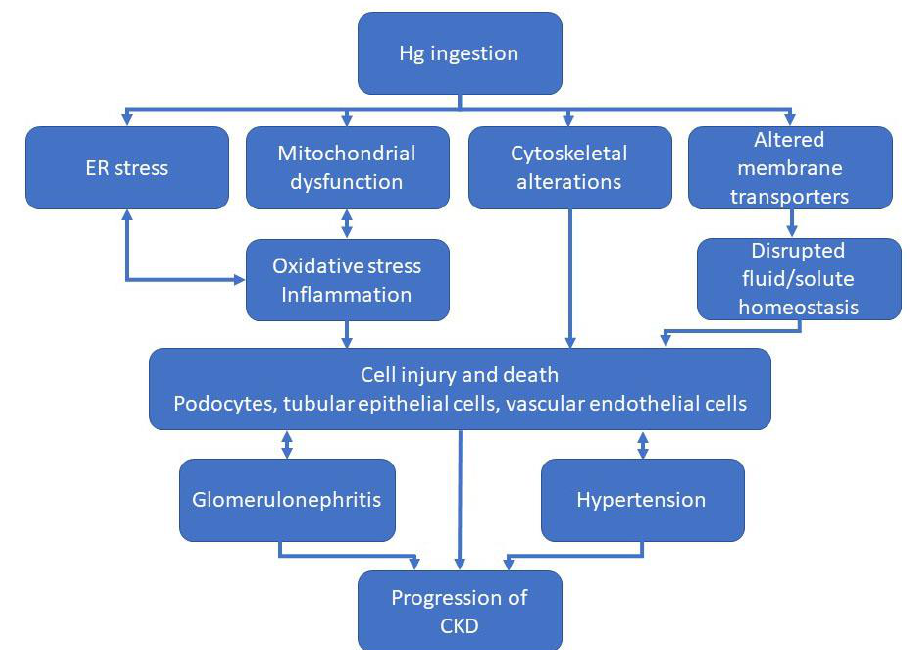
Figure 5. Flowchart outlining major mechanisms involved in mercury (Hg)-induced progression of CKD. Other factors not specified here also play a role in the progression of CKD induced by exposure to Hg.